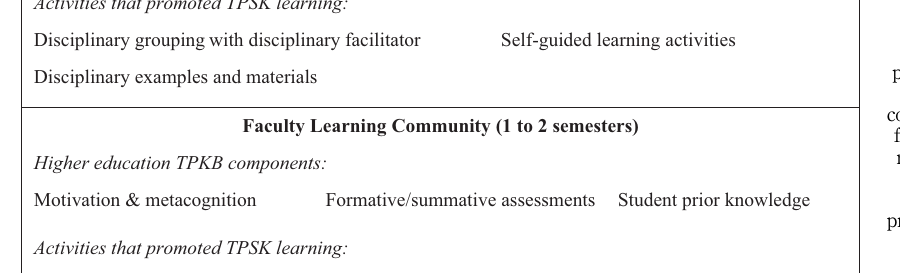
Figure 2. Alignment of